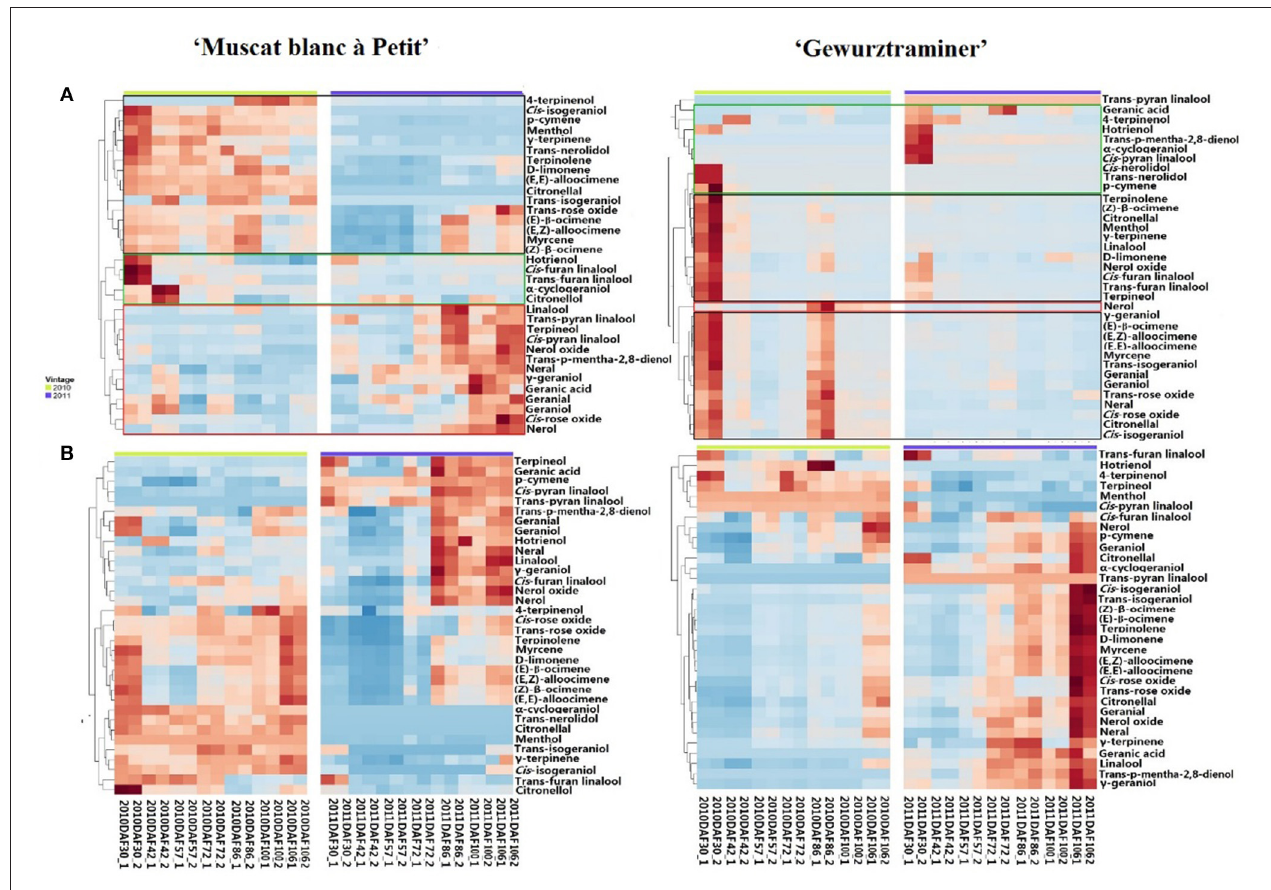
FIGURE 1 | Hierarchical cluster analysis of monoterpenes in developing grapes in 2010 and 2011. Green block represents Cluster I, Black one represents Cluster II and red one represents Cluster III. (A) Free-form monoterpenes in the berries of “Muscat Blanc a Petits Grains” and “Gewürztraminer.” (B) Monoterpenyl glycosides in the berries of “Muscat Blanc a Petits Grains” and